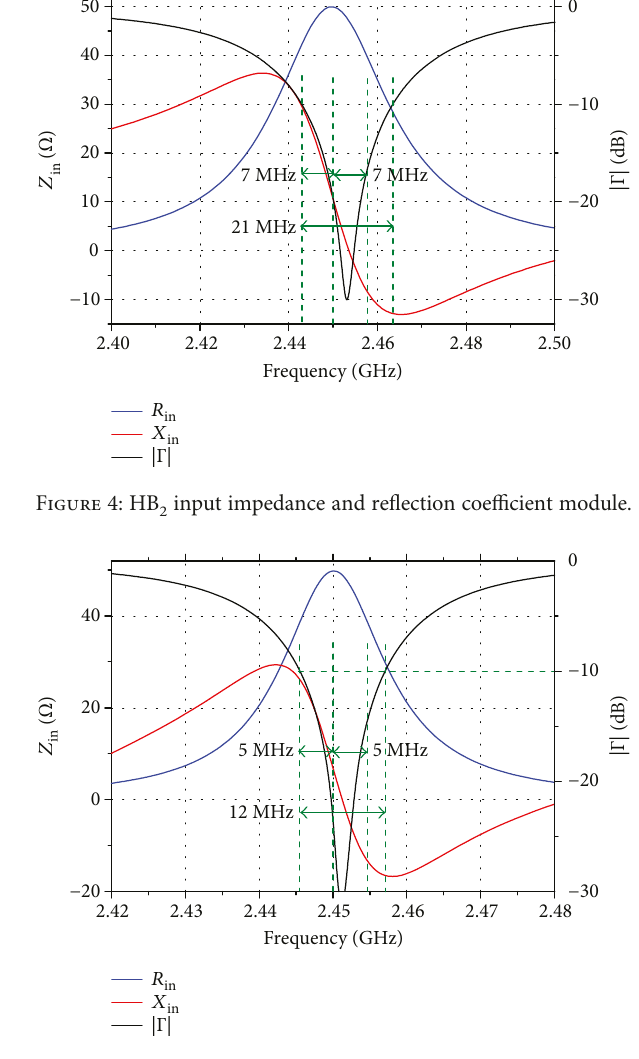
11 (calculated in